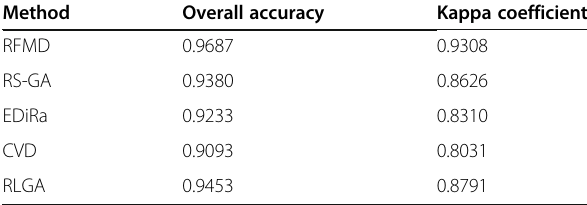
Table 16 Classification results in the banknote